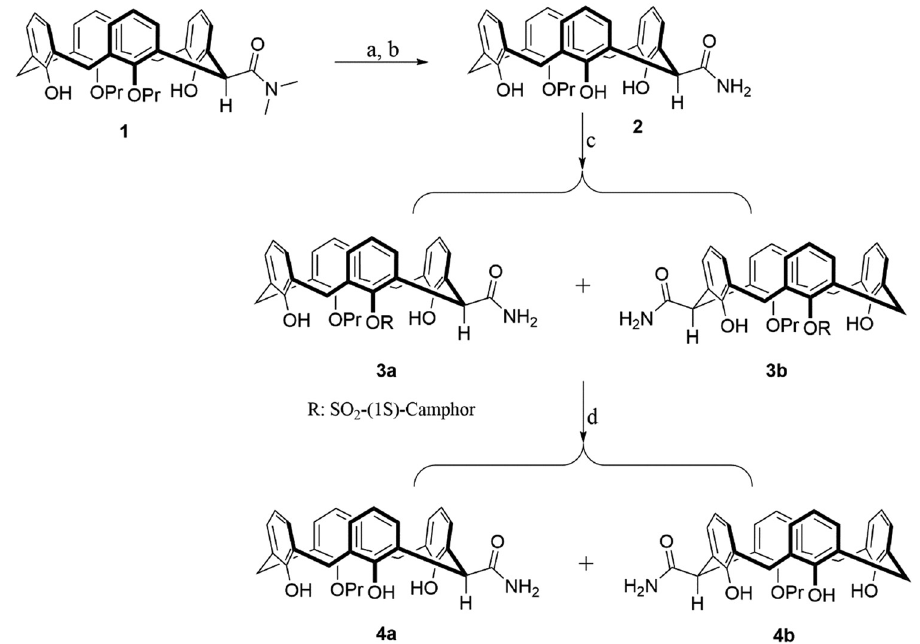
Figure 2: Reagents and conditions: ( a ) methanesulfonic acid, toluene, 120°C; ( b ) NH 3 · H 2 O, 0°C; ( c ) ( 1 S )-(+)- 10 - camphorsulfonyl chloride, Cs 2 CO 3 , CH 3 CN, rt; and ( d ) NaOH, CH 3 CN/H 2 O,